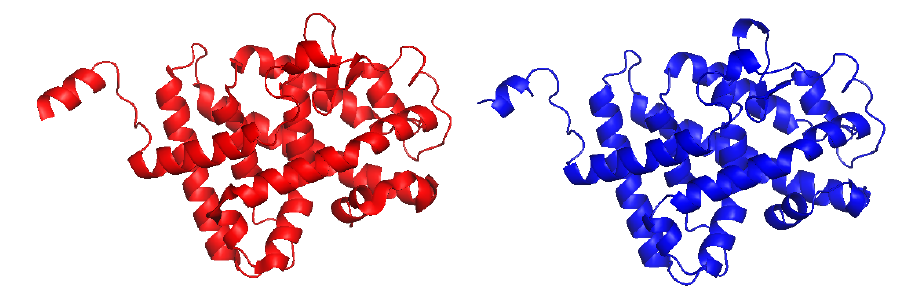
Figure 8. Comparison of the reconstructed model ( right ) with the PDB model ( left